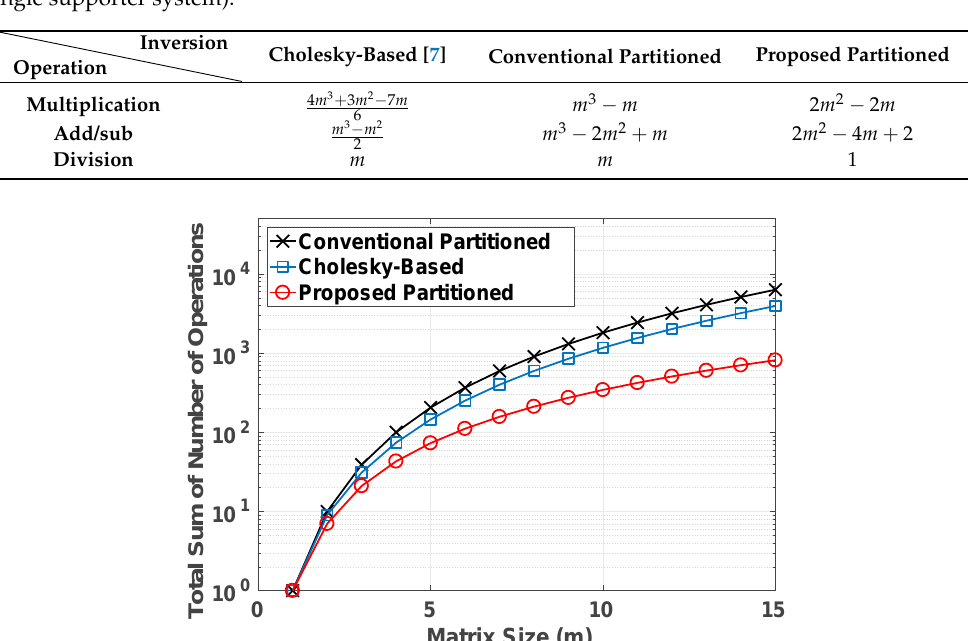
Table 3. Computation Complexity Comparison of input matrix inversion (for m × m matrix 𝐔 and a single supporter system).